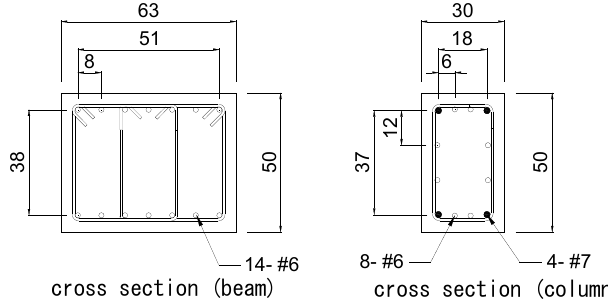
Figure 3. Dimensions of the specimens of RCW1 and RCW2. (unit: cm).